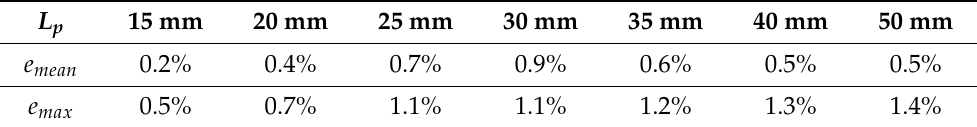
Figure 12. Comparison between the resonant frequency of the SR obtained from numerical simu- lations and those from the corrected equivalent model. The resonant frequency from the original model is shown by the yellow line for reference. Results are plotted for L p = L tag = 30 mm and w = s = 2 mm, while varying d z . Table 2. Mean and maximum percentage error for the resonant frequency estimation using the corrected circuit model for L tag = 30 mm and different L p sizes.